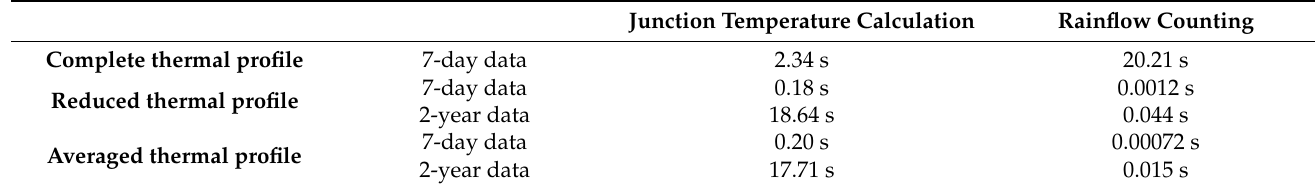
Table 17. Computation time comparison.